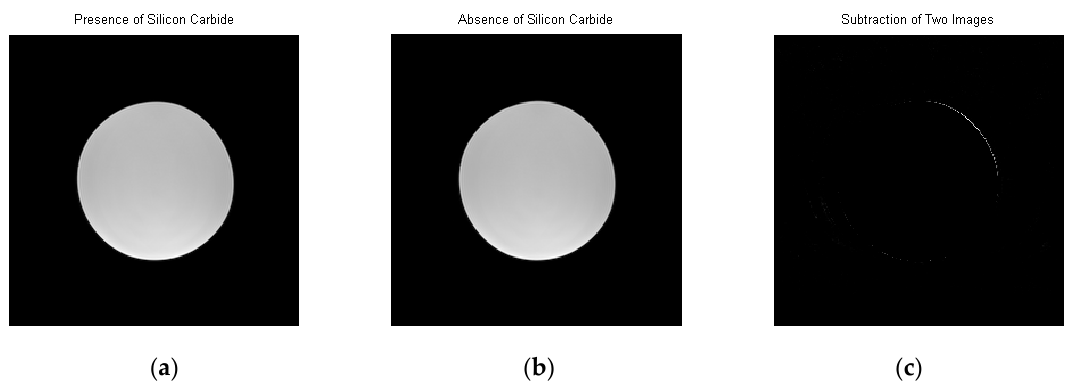
Figure 8. ( a ) The T2-weighted turbo spin echo (T2W) transverse image of the phantom in the presence of silicon carbide sheet; ( b ) the same image in the absence of the sheet; ( c ) the subtraction of these two images (a and b).